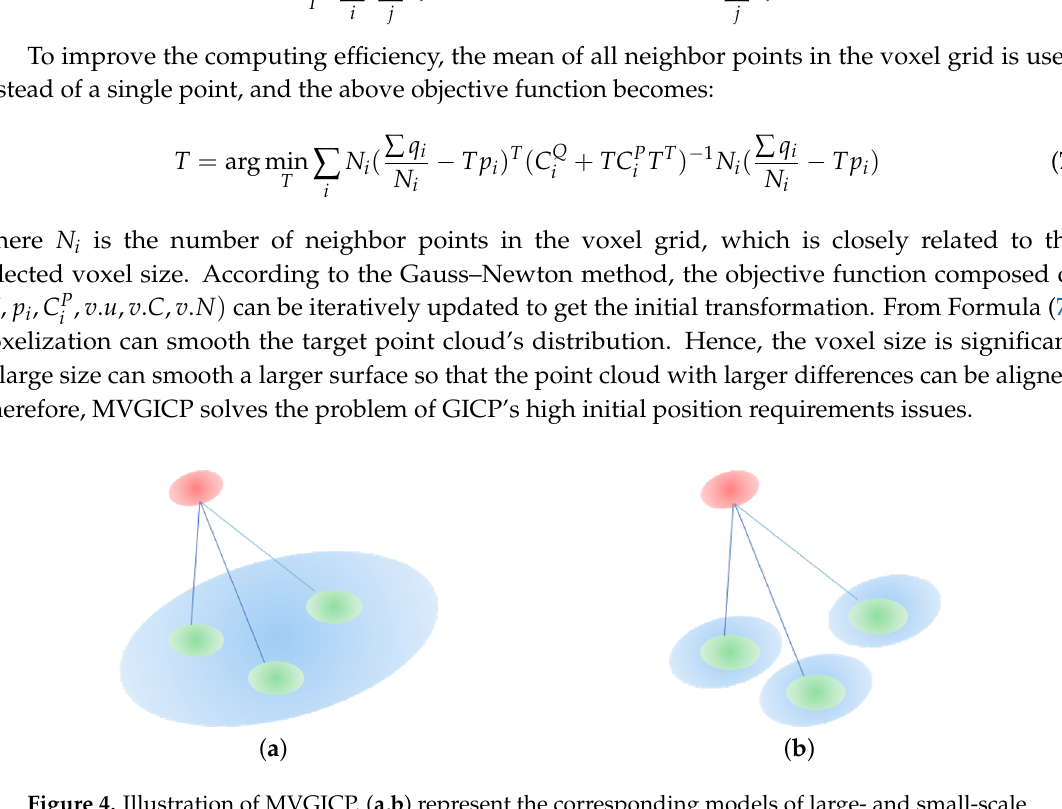
Figure 4. Illustration of MVGICP. ( a , b ) represent the corresponding models of large- and small-scale MVGICP distance calculation, respectively. The red, green, and blue circles represent the source point cloud distribution, target point cloud distribution, and voxel,